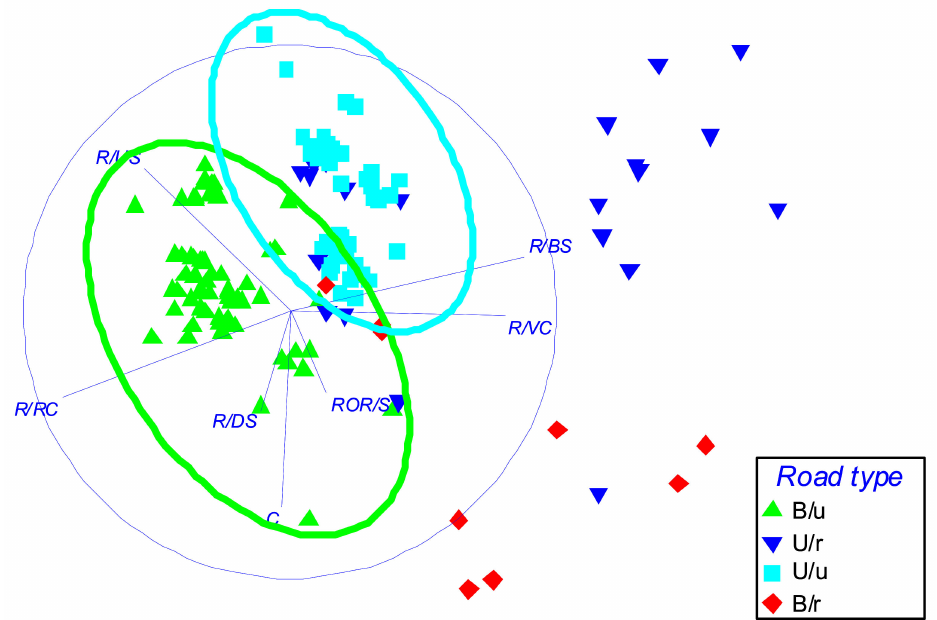
Figure 4. Biplots of geometric characteristics and soil covers using multidimensional scaling (MDS) routine in four road types in Hell í n (Central-Eastern Spain). Legend: R/US = Road Upstream Slope; R/DS = Road Downstream Slope; R/BS = Road Bare Soil; R/RC = Road Rock Cover; R/VC = Road Vegetation Cover; ROR/S = Rill-On-Road Slope; C = Connectivity; B/u = Unpaved road in burned forest; B/r = Rock-paved road in burned forest; U/u = Unpaved road in unburned forest; U/r = Rock-paved road in unburned